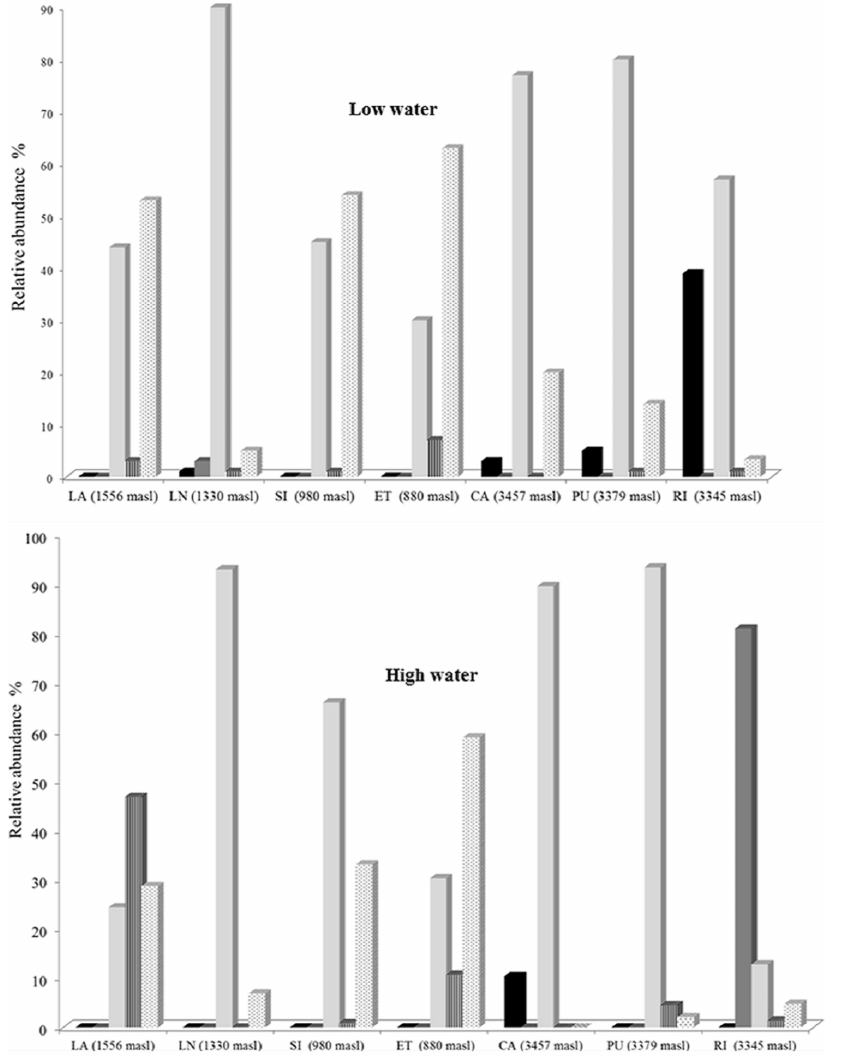
Figure 2. Relative abundance of subfamilies for each season in the seven reaches (Puna and Chaco Serrano streams) sampled in the